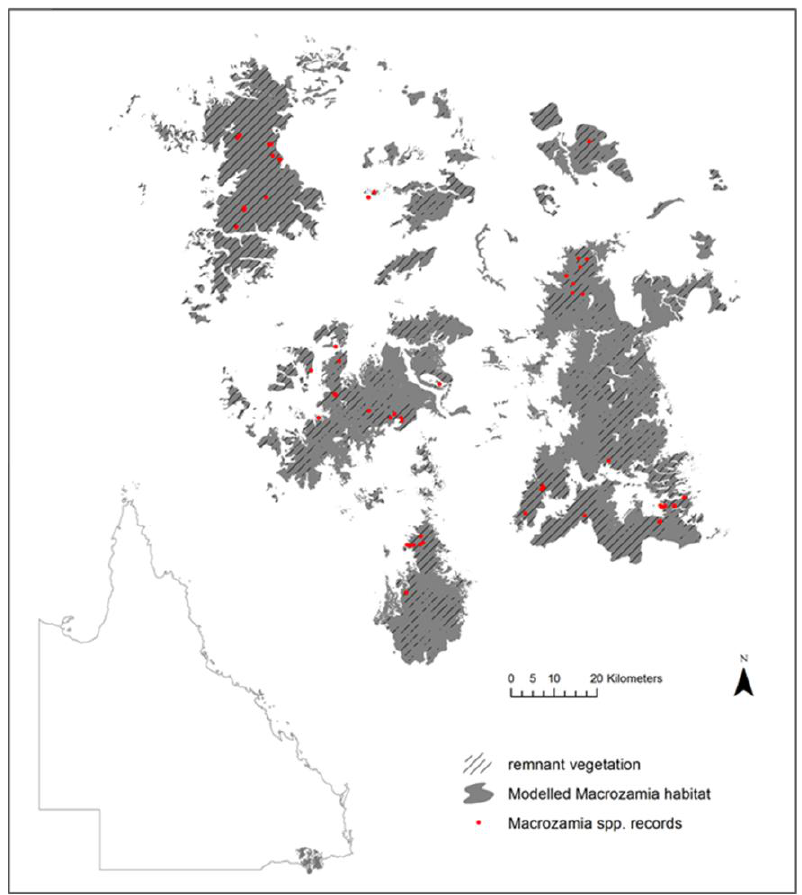
Figure 1. Current modelled range and species records of five Macrozamia species in the Darling Downs region of Queensland, Australia. Hatching indicates the extent of the current range covered by remnant